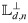
Bio-mechanical responses in wild type and MYOII-KD case.(A,B) Time courses of the cell length L (A) and the rate change L′(t) of the cell length (B) in wild type and MYOII-KD. (C) Time courses of deformation Ld,n⊥ of the nucleus in wild type and MYOII-KD. (D) Time courses of the average sensing pressure (ps; top panel), myosin II level ([mb]; middle panel), and the stiffening rate (r[mb]; bottom panel) in wild type and MYOII-KD.